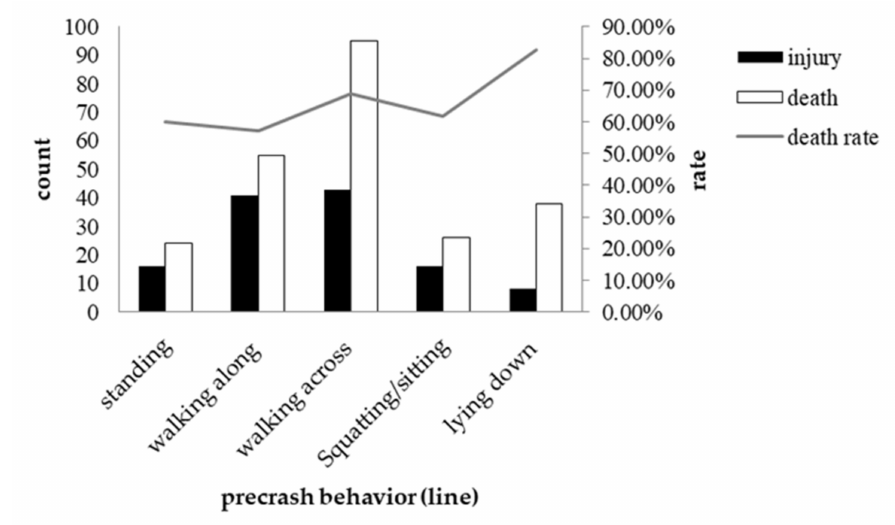
Figure 8. Occurrence of different crash severities by different precrash behaviors along the line.